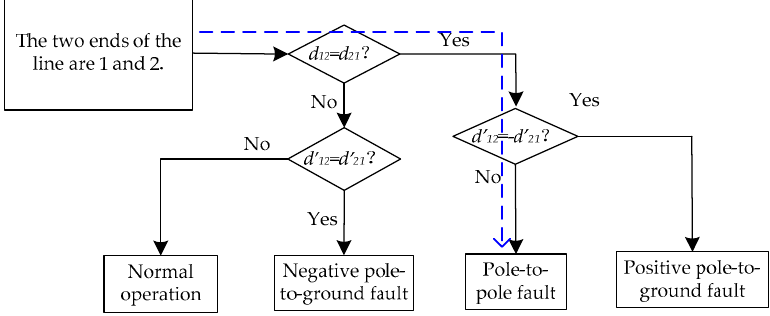
Figure 14. The algorithm flowchart under pole ‐ to ‐ pole short ‐ circuit fault.